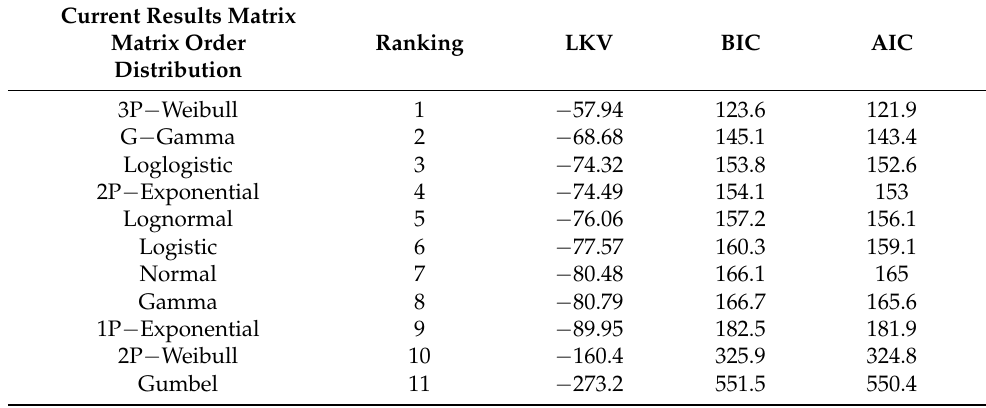
Figure 7. Cleat reliability values for an 80.2% confidence level for the captive guide. Table 6. Classification of the distribution law acceptance for the captive guide.